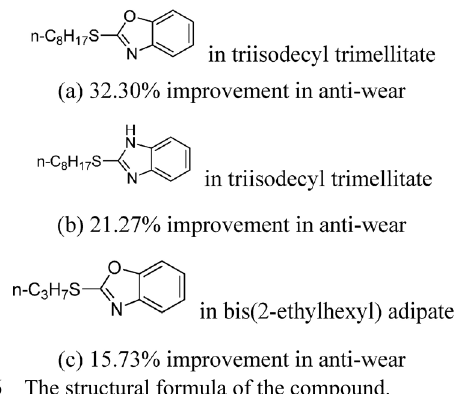
Fig. 26 The structural formula of the compound. To some extent, it can be said that the three isos- teres were revealed via molecular modification. In contrast, among these eight compounds, some exhibited adverse anti-wear effects, as shown in Figs. 27(a) − (c).